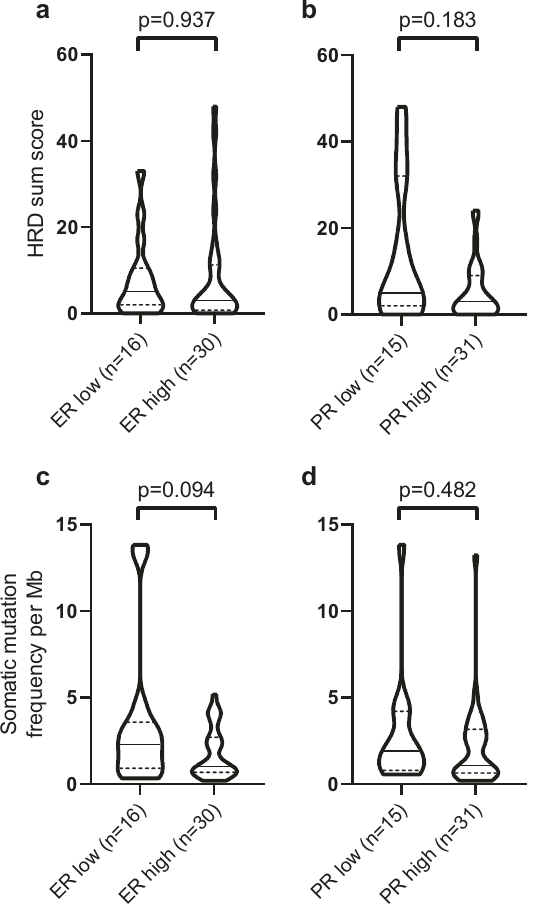
Fig. 2 Genomic characteristics de fi ned by hormone receptor expression status. CN pro fi les were used to generate a homologous recombination de fi ciency score for each sample and compared between ( a ) ER-low and ER-high cancers and ( b ) PR-low and PR-high cancers. The collective number of coding mutations per/Mb in each sample was compared between ( c ) ER-low and ER-high cancers and ( d ) PR-low and PR-high cancers. Pairwise comparison p-values were calculated using a negative binomial model, adjusted using a false discovery rate method. The black line within the violin plot represents the median. The dashed lines indicate the upper the lower